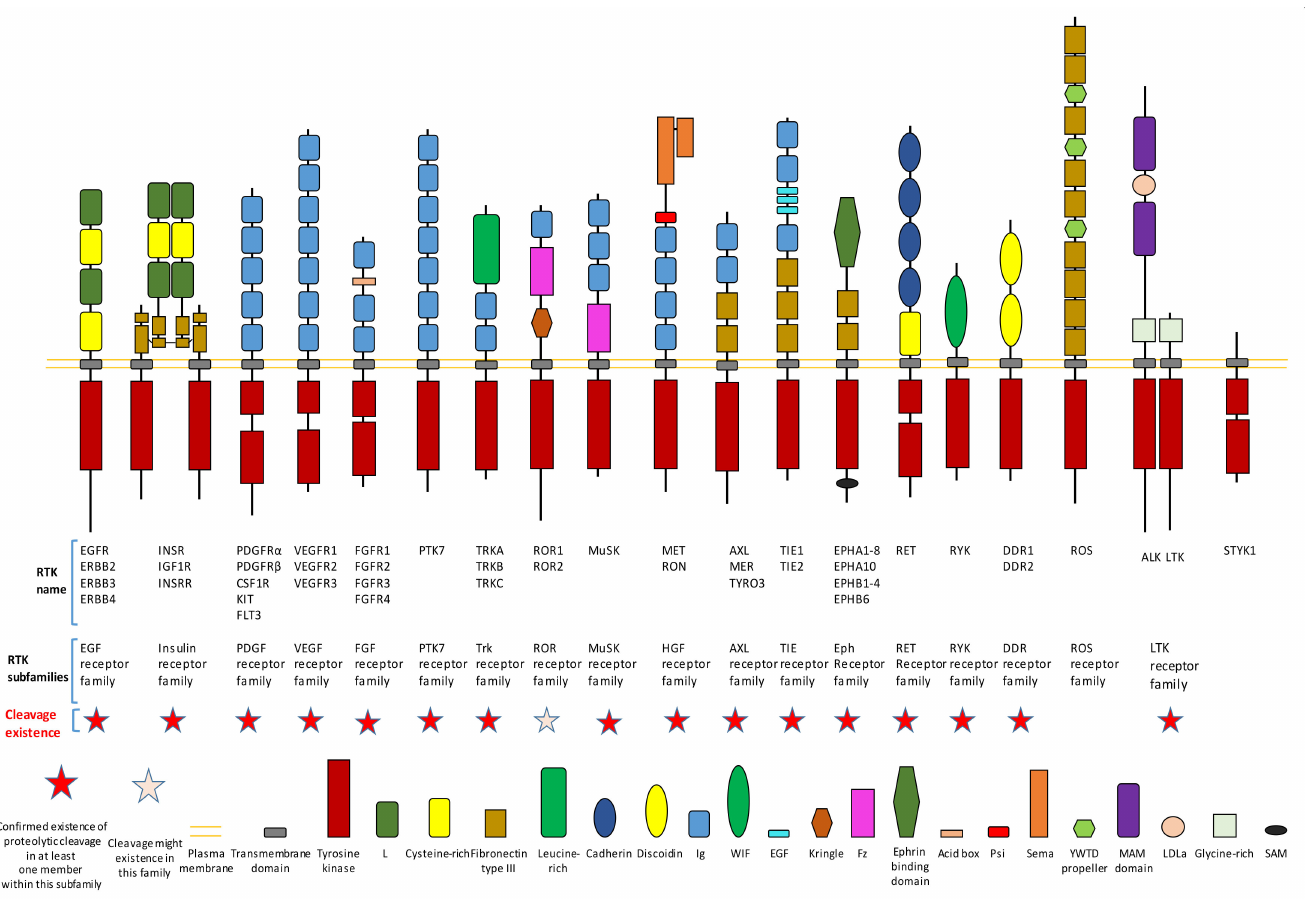
Figure 1. Existence of proteolytic cleavage in different subfamily of receptor tyrosine